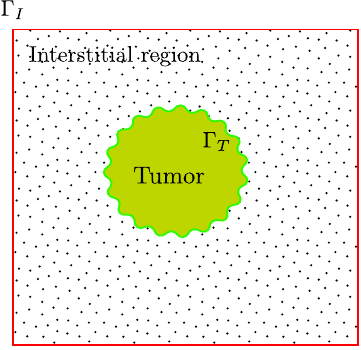
Figure 3. Outline of boundary decomposition ∂ Ω = Γ T ∪ Γ I